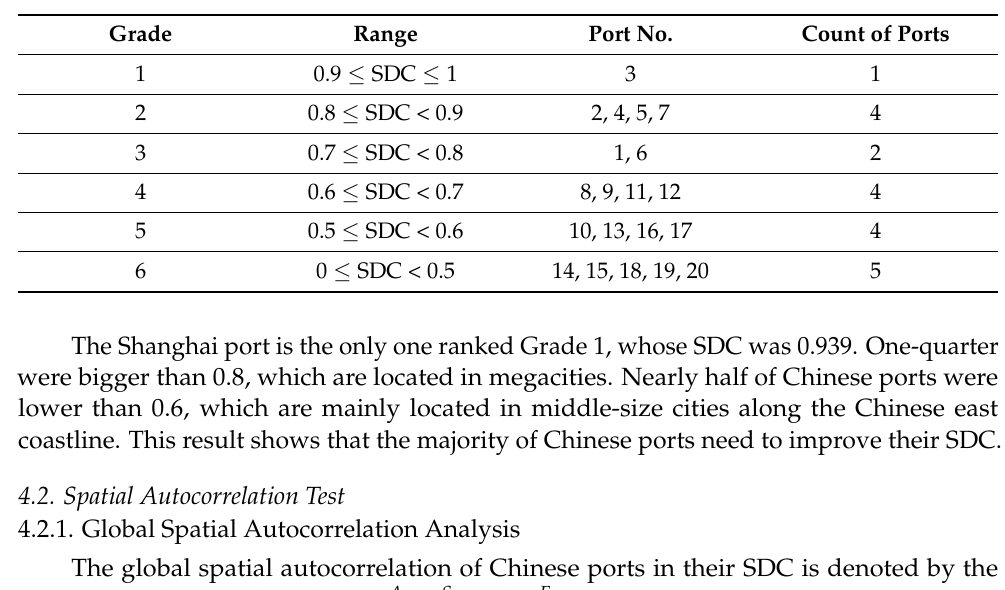
Table 4. Classification of Chinese ports by their SDC.